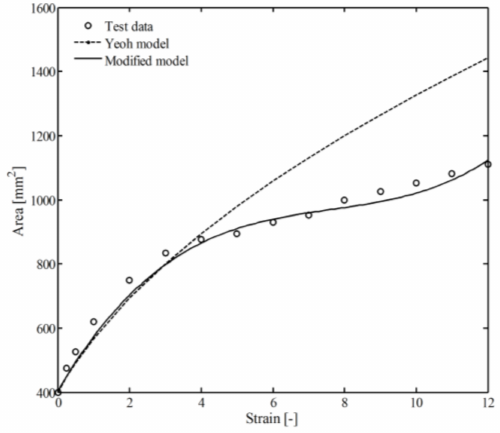
Figure 8. Relationship between the marked area and tensile strain [48].